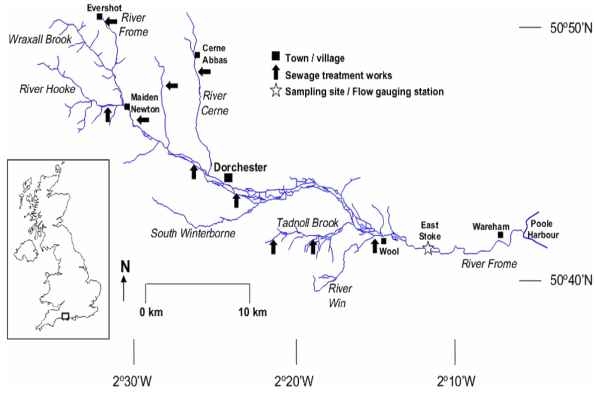
Figure 1. Schematic map of Frome Catchment showing monitoring points (from Bowes et al.,